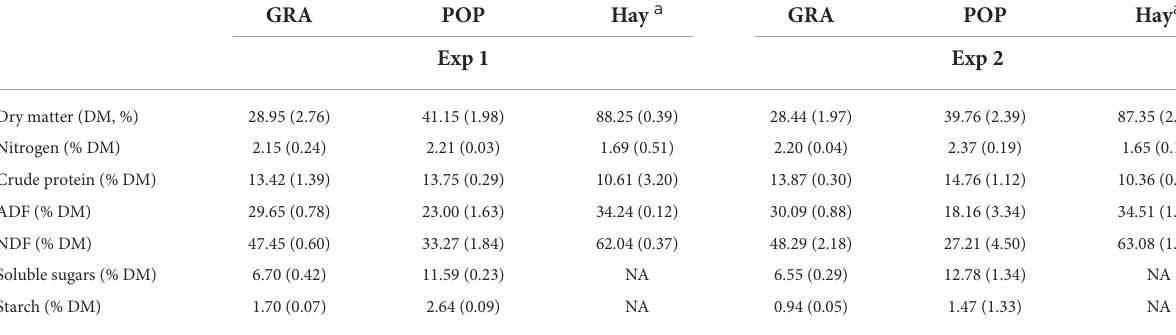
TABLE 2 Mean (SD) chemical composition of the feed (GRA: cut grass, POP: poplar leaves) used in Experiment 1 and Experiment 2. GRA POP